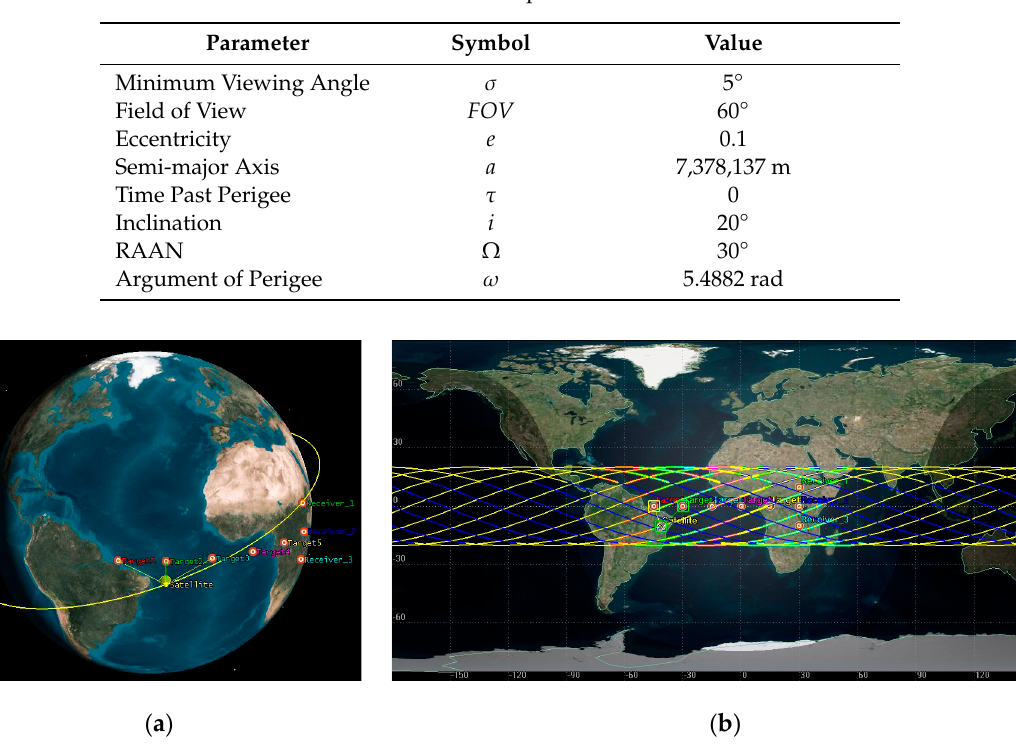
Figure 7. Example of orbits of a low Earth orbit (LEO) satellite. ( a ) 3D graphic; ( b ) 2D graphic. Table 4. Data of task attributes. Table 1. Earth parameters.